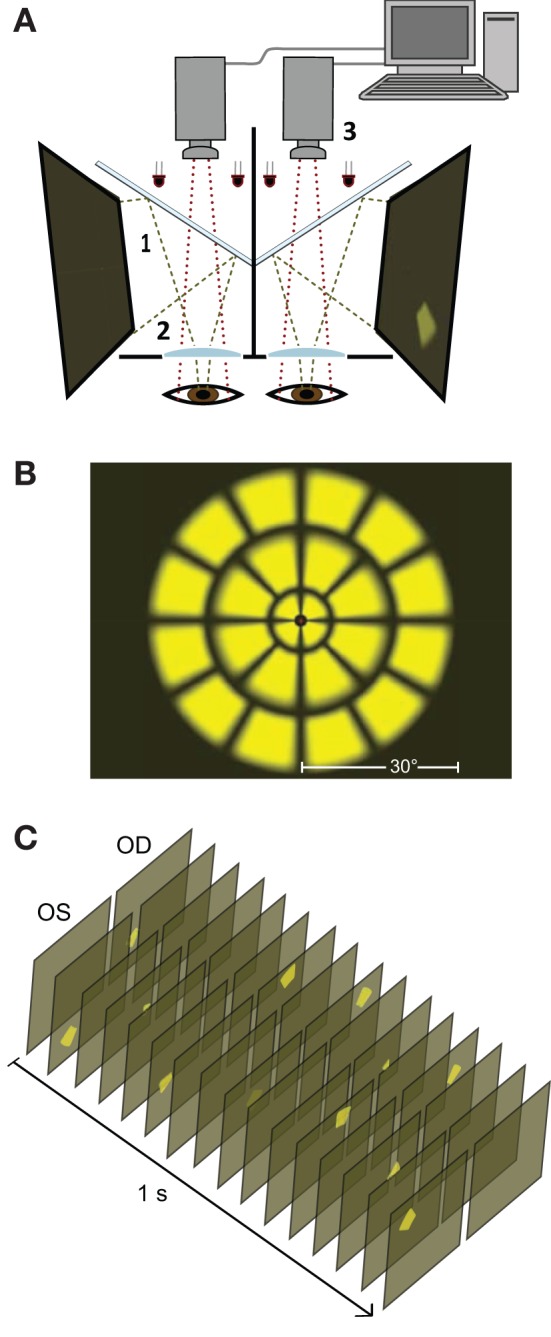
Stimulus presentation. (A) Stimuli are presented on two liquid crystal displays (LCDs, 1) with viewing distance set to optical infinity (2). Cold dichroic mirrors reflect the LCDs while allowing infrared light to illuminate subjects' eyes. Responses in both pupils are monitored using two infrared video cameras (3). (B) All the stimulus variants used in this study (Table 1) employed sub-sets of a basic 24 test-region per eye array. The array comprised 3 rings of stimuli extending ± 30° from fixation. (C) A 1 second duration representative excerpt of the stimulus sequence showing temporally and spatially sparse multifocal presentation for left (OS) and right (OD) eyes. This sample is consistent with the All test-regions both eyes 3 stimuli/s/hemiretina stimulus variant (Table 1, top row).